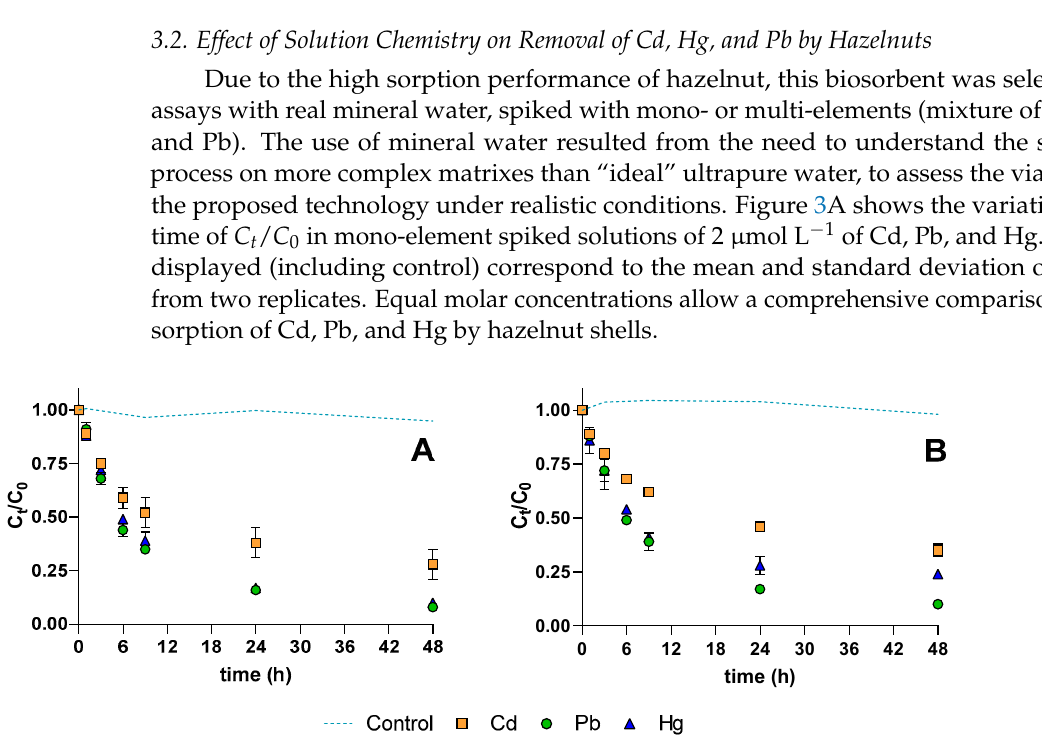
Figure 3. Normalized concentration (C t /C 0 ) of cadmium (Cd), lead (Pb) and mercury (Hg) in mineral water spiked with 2 µmol L − 1 of each element: ( A ) mono-element solution; ( B ) multi-element solution.